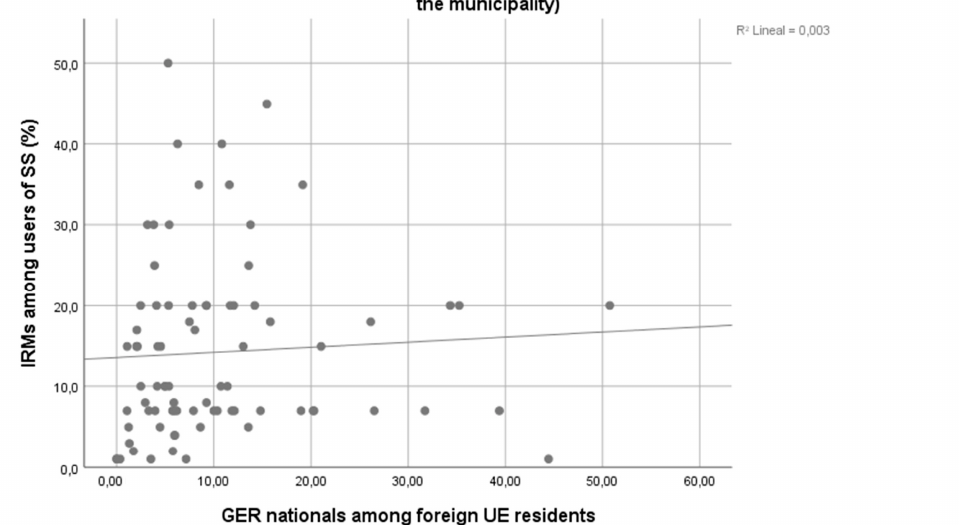
Figure 5. Retirement migrants among users of Social Services and share of German elderly citizens. Source : Own elaboration with primary data from our telephonic survey with Social Services’ coordinators and data from Local Registers. Each dot is a municipality. In the horizontal axis one can see the share of German nationals among foreign residents. In the vertical axis one can see the share of European elderly among claimants of the Social Services. The line is the regression line for a linear regression model with the two variables.